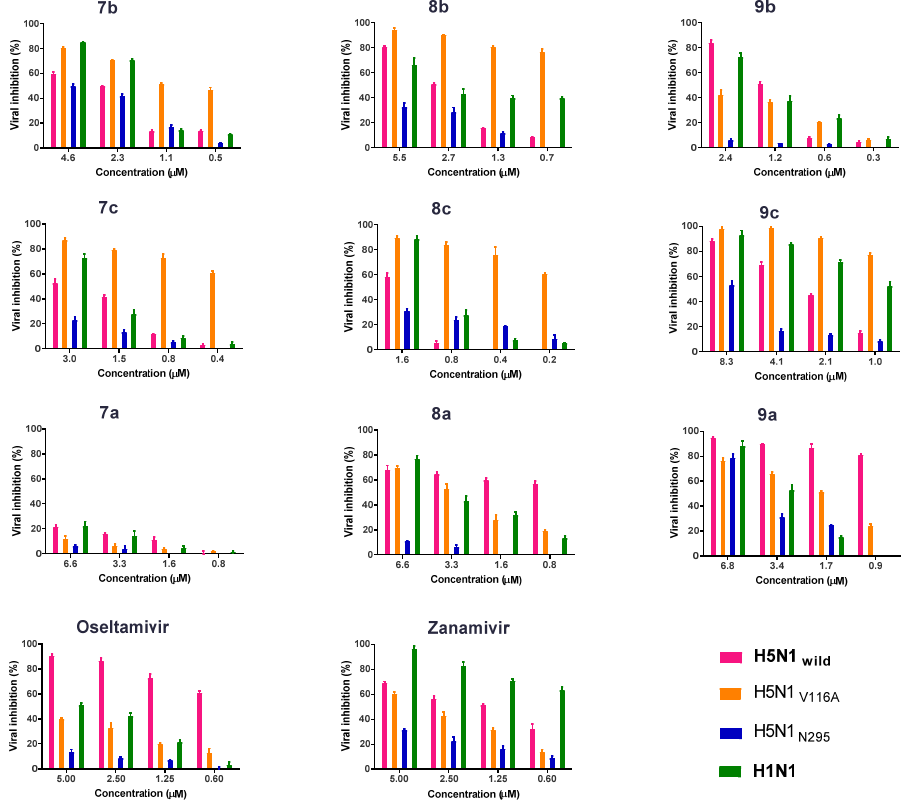
Figure 6. Antiviral activity of the new synthetic compounds, oseltamivir, and zanamivir against the H5N1 wild , H5N1 V116A , H5N1 N295S , and H1N1 viruses using a plaque reduction